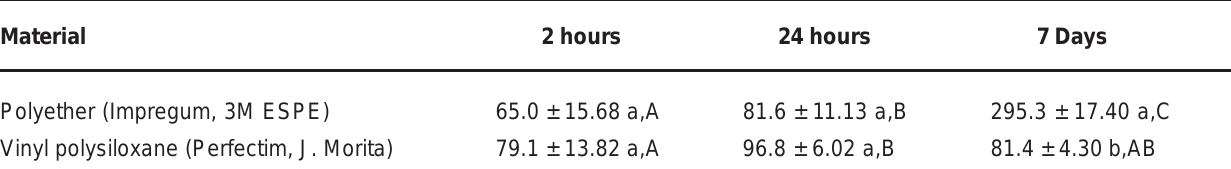
Means followed by the same lowercase letters in columns and uppercase letters in lines indicate no statistically significant difference at 95% confidence